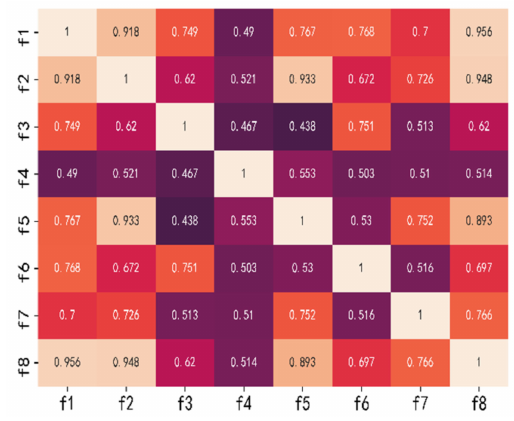
Figure 5. Thermodynamic diagram of agricultural sample